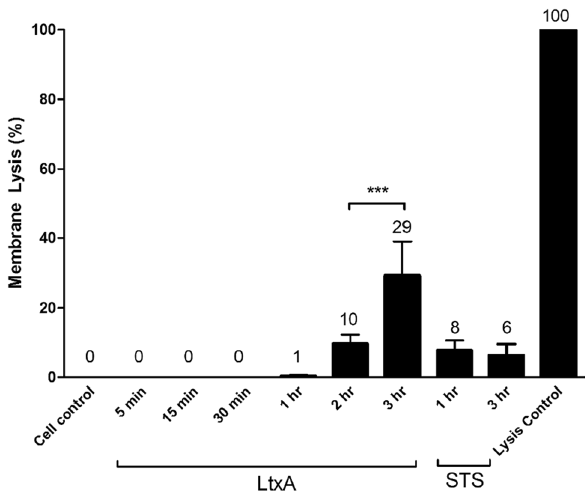
Figure 2. LtxA induced membrane lysis is not the cause of ATP expulsion. Wild-type Jurkat cells were treated with 0.3 µg/mL of LtxA for varying time points or with 1 µM of STS for 1 and 3 h. Membrane lysis was assessed using the Cytotox-ONE Homogenous Membrane Integrity Assay from Promega. Membrane lysis is expressed as a percentage of lactate dehydrogenase (LDH) relative to the control cells.